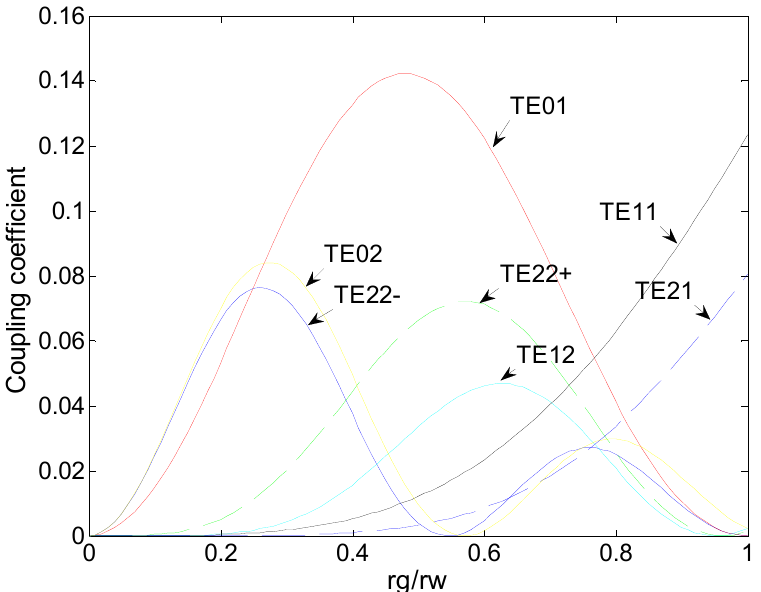
Figure 3. The dependence of the coupling coefficient on guiding-center radius for the TE 02 mode and possible competing modes.